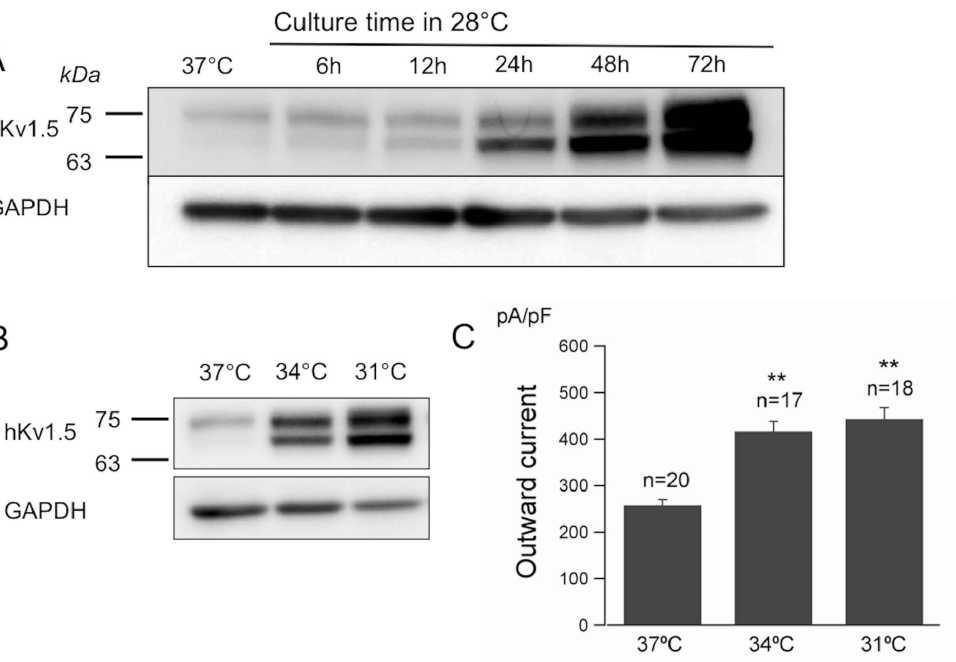
Figure 3. Low temperature cultivation increases hKv1.5 in a time- and temperature-dependent manner. (A) Time chase of the hKv1.5 expression for the 28 u C culture at the indicated times. (B) Western blot analysis for the hKv1.5 protein under two conditions of mild hypothermia (31 u C and 34 u C). (C) A summary of the outward hKv1.5 currents in CHO-hKv1.5s, cultured at 34 u C and 31 u C (** P , 0.01 vs 37 u C culture).